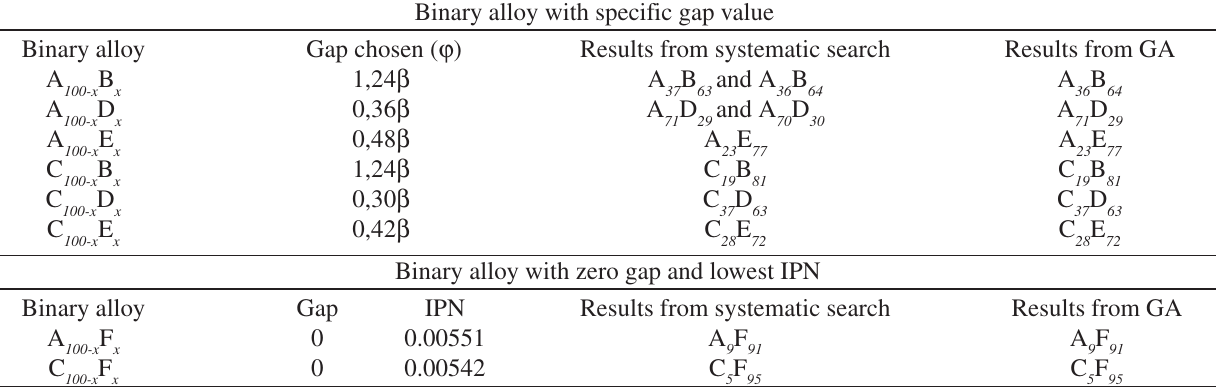
Table 1. Results obtained for systematic search and GA. β = 2.5 eV.